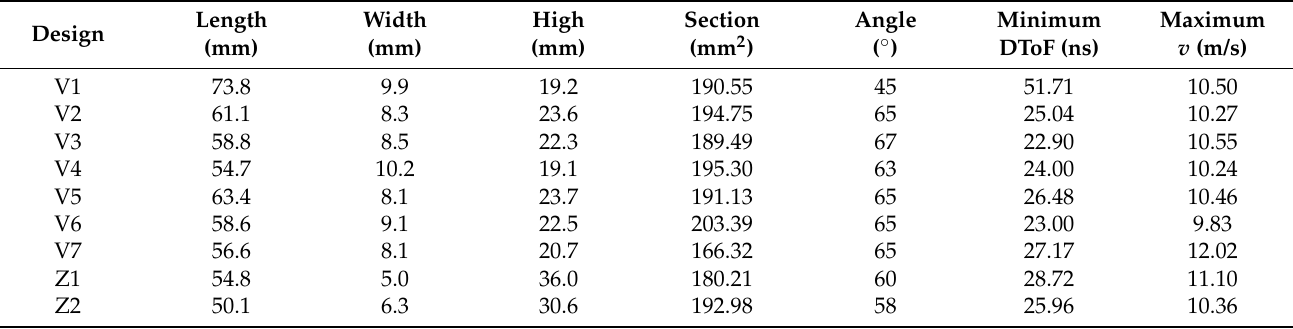
Table 1. Manufactured and tested mechanical designs.